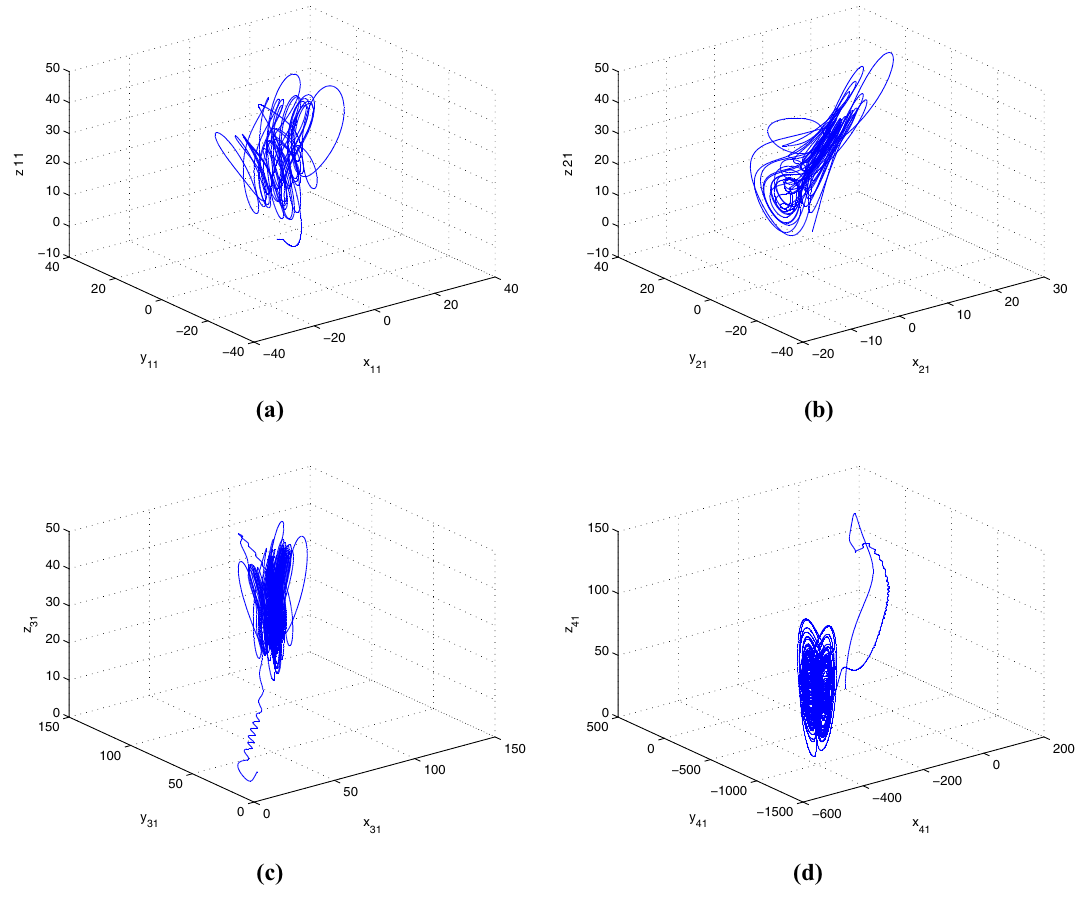
Fig. 2 Phase portraits of hyperchaotic systems in a x 11 − y 11 − z 11 space, b x 21 − y 21 − z 21 space, c x 31 − y 31 − z 31 space, d x 41 − y 41 − z 41